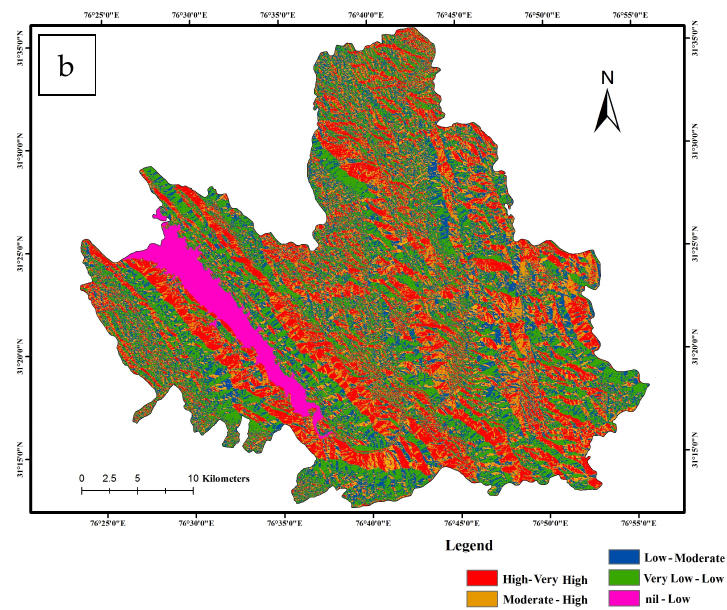
Figure 7. ( a ) Aspect map of Bilaspur district; ( b ) Aspect index map of Bilaspur district.